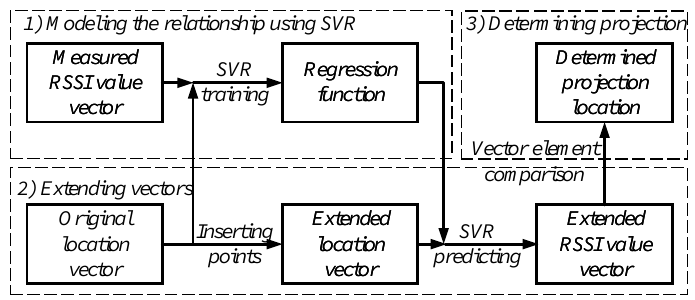
Figure 3. The process of determining the projection of a sensor node on the